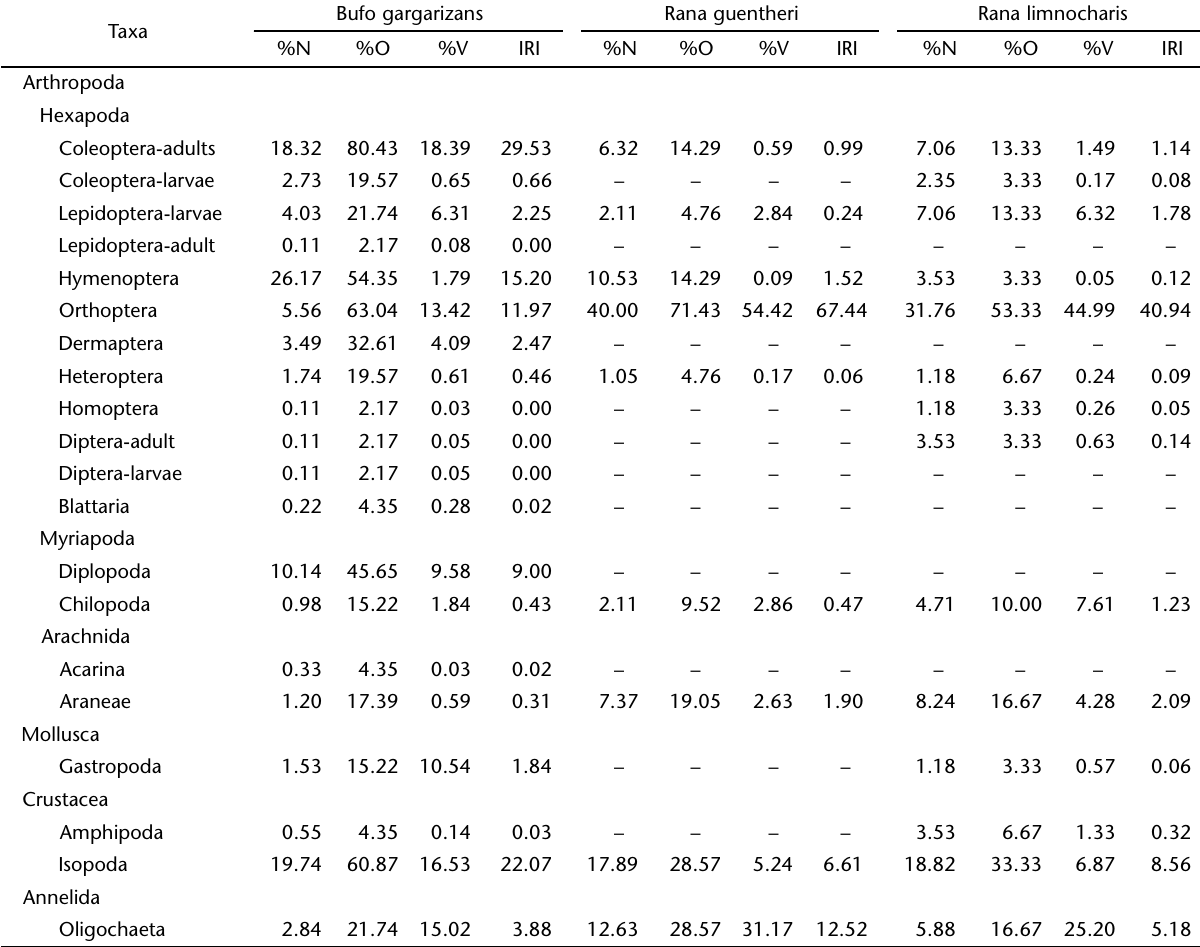
Table I. Prey categories with their respective absolute values and relative abundance (%N), frequency of occurrence (%O), volume (%V) and index of relative importance (IRI).